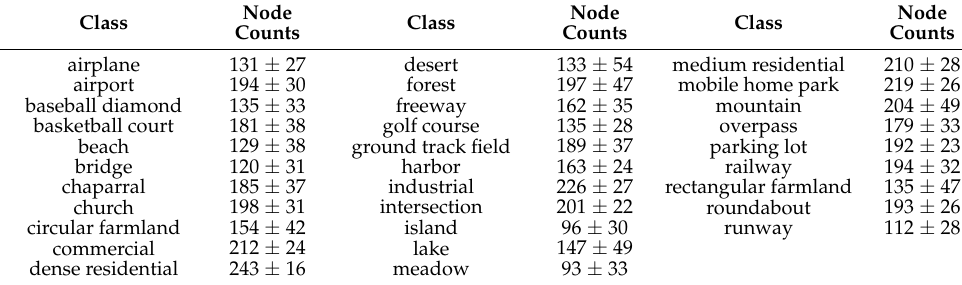
Table 5. Node counts of each category in the OPTIMAL-31 dataset.